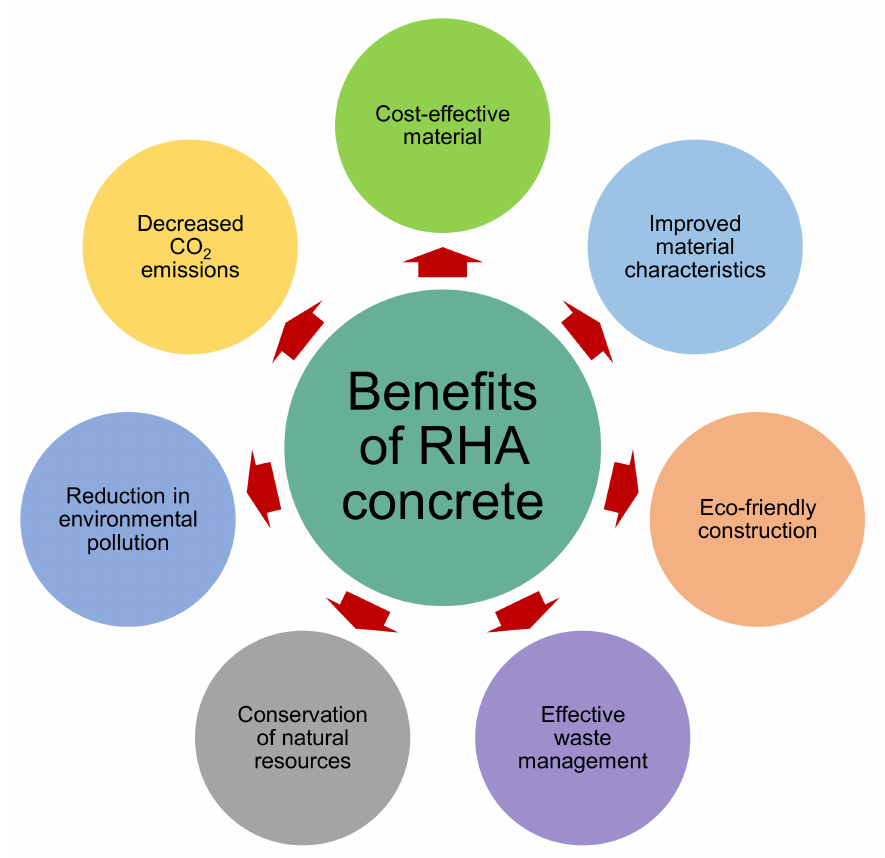
Figure 1. Benefits of RHA